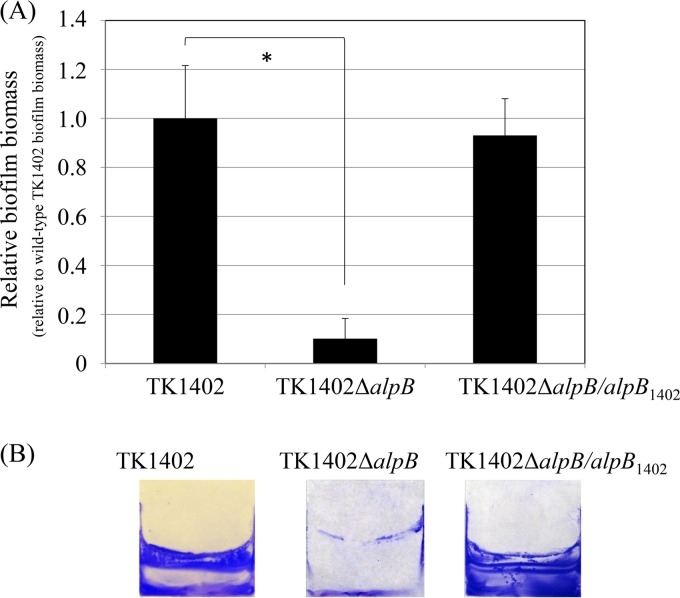
Biofilm formation by wild-type TK1402 (TK1402), its isogenic alpB mutant strain (TK1402ΔalpB), and a TK1402 alpB restored strain (TK1402ΔalpB/alpB1402). (A) Quantification of H. pylori biofilms formed on glass coverslips after 3 days by CV staining and ethanol elution. The data are expressed as the means ± 1 standard deviation from at least three independent experiments. (B) CV-stained biofilm of wild-type TK1402 (TK1402), TK1402ΔalpB, and TK1402ΔalpB/alpB1402 strains of H. pylori grown on the surfaces of glass coverslips in brucella-FCS broth. An asterisk indicates significant difference (P < 0.05) relative to the level of wild-type biofilm biomass.